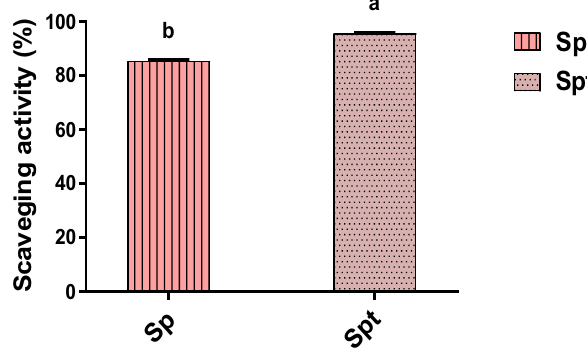
Figure 2: Tannin content in methanolic extracts of SP and SP sup - plemented with thiamine for 21 days of culture. Di ff erent letters mean signi fi cant change between groups ( p < 0.05 ) .